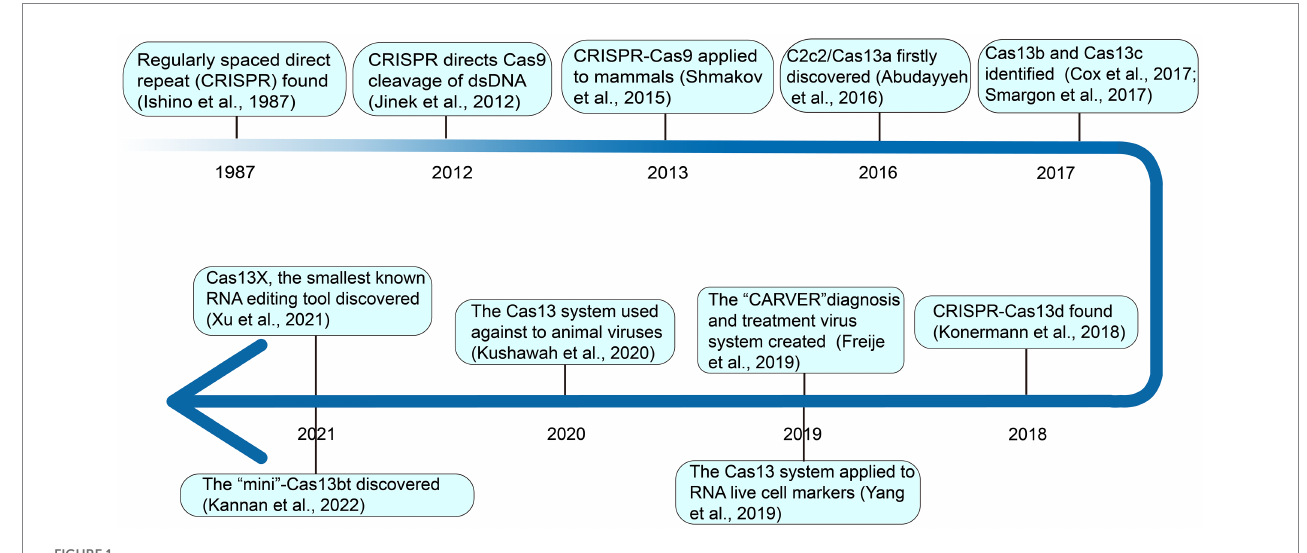
FIGURE 1 The discovery and application timeline of CRISPR-Cas13